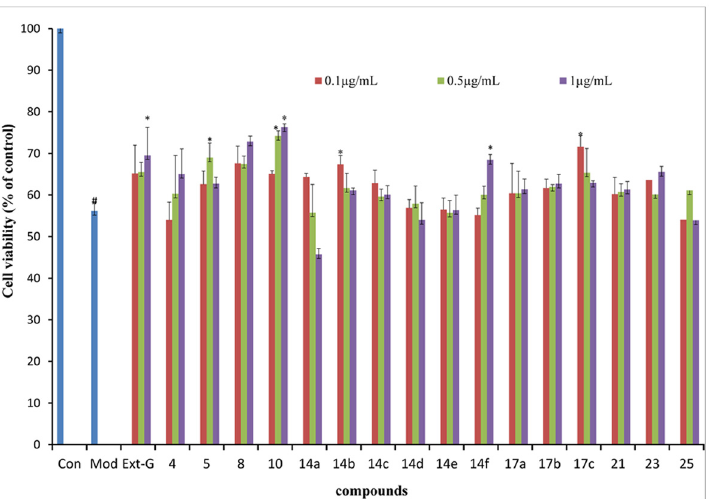
Fig 3. Gigantol analogs at 0.1, 0.5, and 1.0 μ g (cid:1) mL -1 on viability of HLECs treated with 250 mmol (cid:1) L -1 D- galactose for 72 h. Cell viability was determined by the MTT assay in the absence (Con) and presence (all other groups) of D-galactose. Ext-G refers to gigantol extracted from dendrobii. Viability (mean ± SD, n = 3) is expressed as the percentage of viable cells in the treatment to those of the Con. # P < 0.01 vs. Con, * P < 0.05 vs.